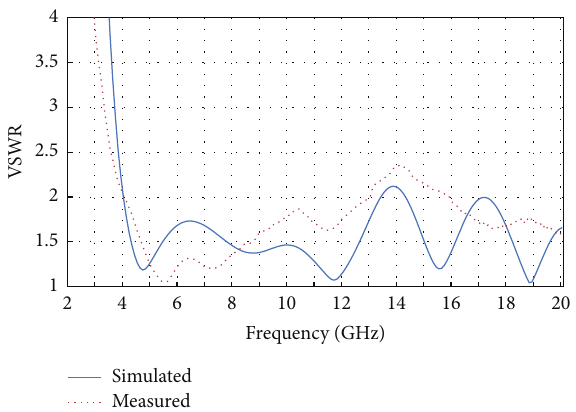
Figure 5: Comparison of simulated and measured VSWR.